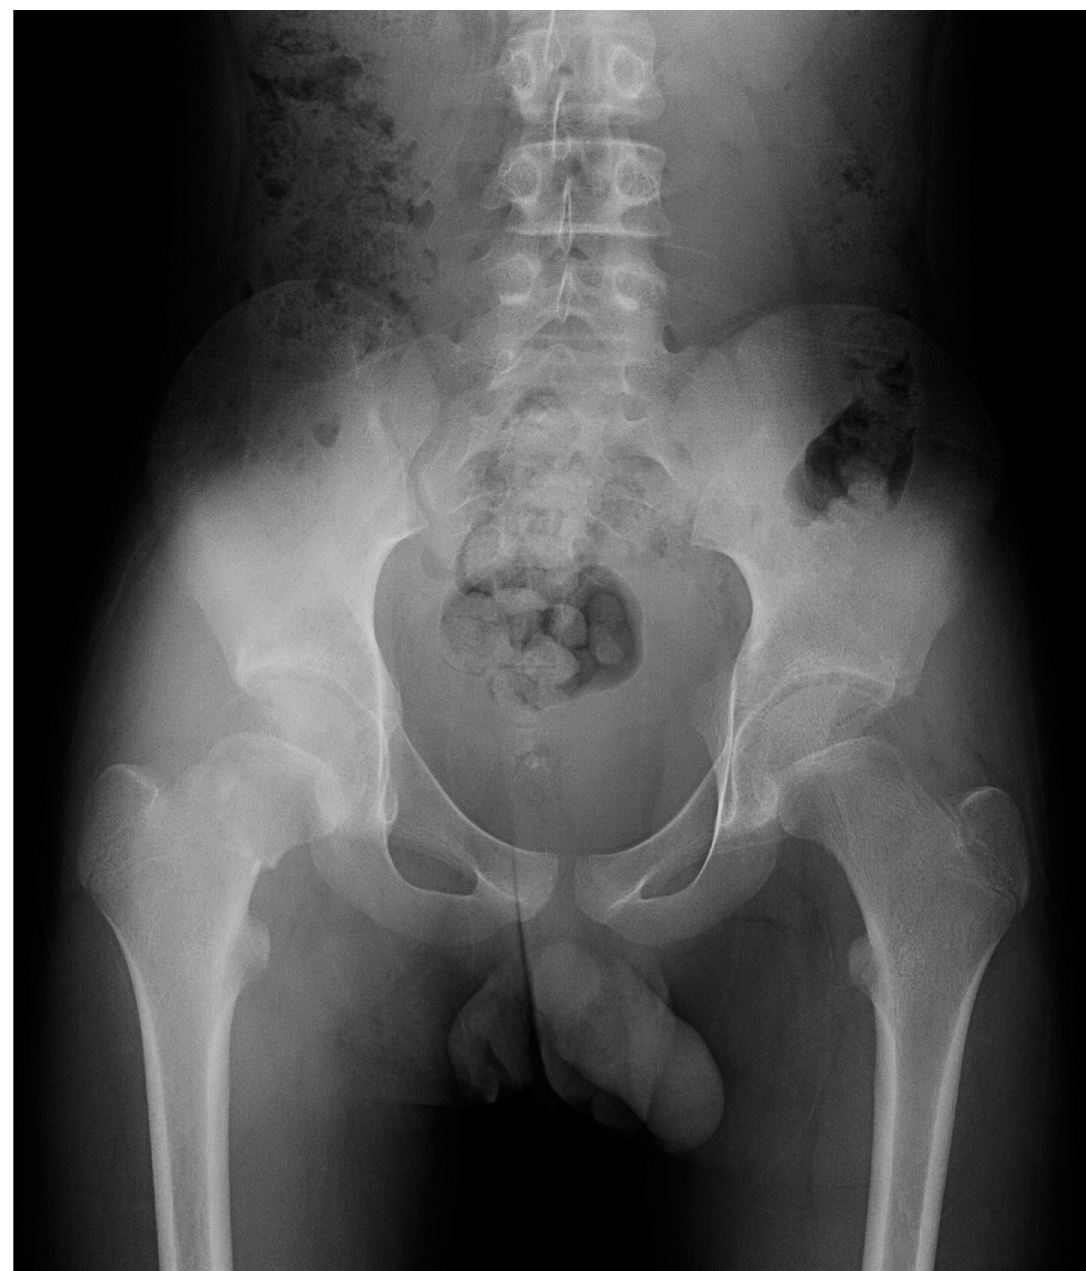
Fig 4. Fracture classification and displacement degree. Radiograph showing a Delbet type-II femoral neck fracture with insignificant displacement.